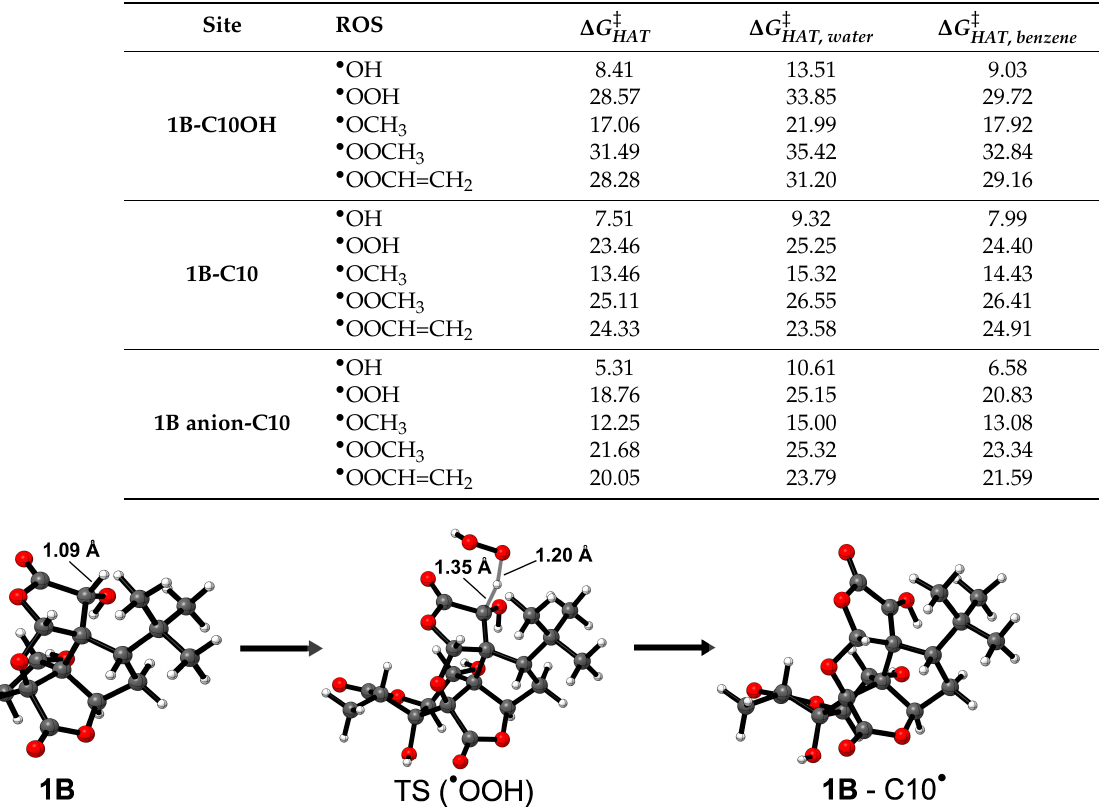
Table 3. Gibbs free activation energies ( ∆ G ‡ kcal mol − 1 ) computed in gas phase, water and ben- HAT zene of 1B and the 1B anion for the scavenging of • OH, • OOH, • OCH 3 , • OOCH 3 and • OOCH=CH 2 via HAT from C10 and C10OH. Level of theory: (SMD)-M06-2X/6-311+G(d,p)//M06-2X/6-31G(d).